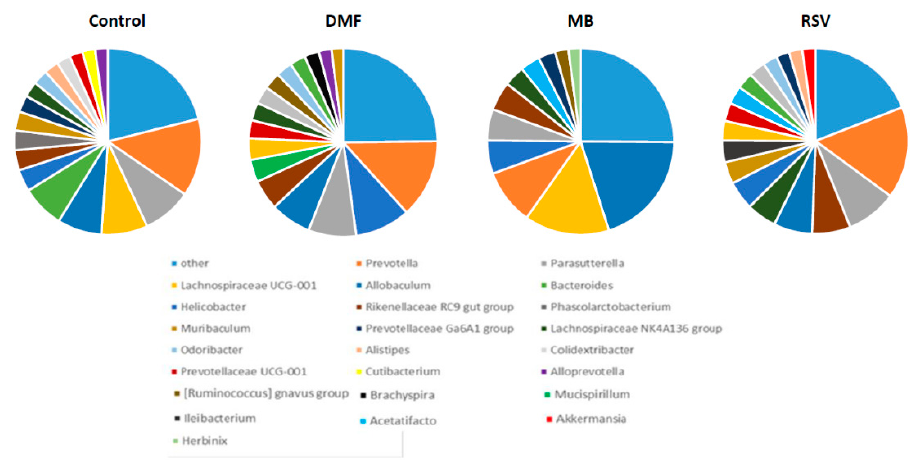
Figure 11. Predominant genera in the gut microbiome. Control n = 8, DMF = 6, MB = 6, RSV =